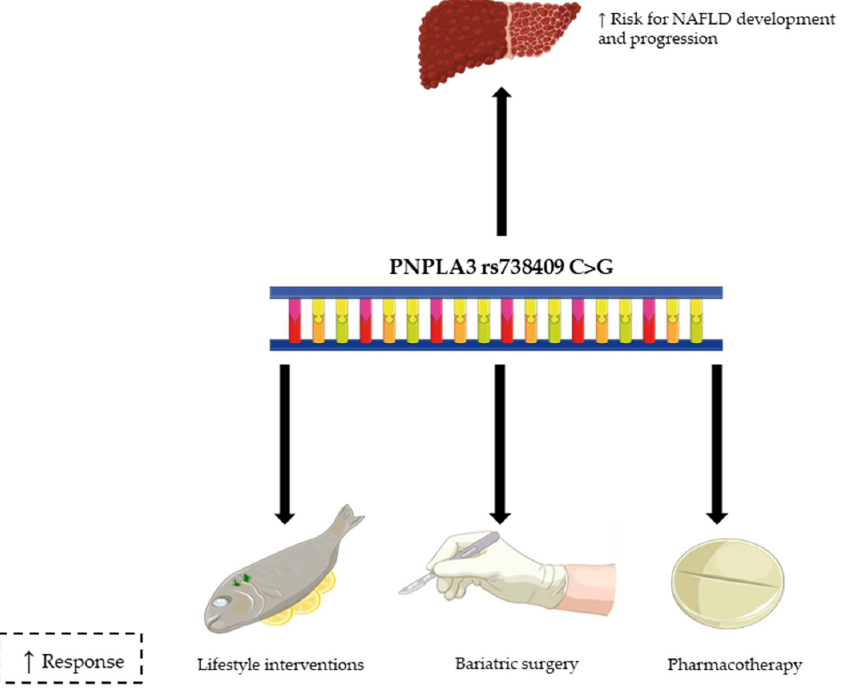
Figure 1. The role of PNPLA3 rs738409 C > G variant in NAFLD. PNPLA3 I148M is associated with NAFLD development and progression, and the interplay between this variant and environmental factors, including dietary habits, seems to be crucial in the pathophysiology of the disease. PNPLA3 I148M presence may also be related to an increased response to lifestyle interventions, bariatric surgery and certain types of therapeutic agents, such as the combination of sodium-glucose cotransporter 2 inhibitors and polyunsaturated fatty acid (PUFA). PNPL3: patatin-like phospholipase domain-containing protein 3; I148M (rs738409 C > G): isoleucine to methionine exchange at the amino acid position 148 due to cytosine to guanine transversion in rs738409); NAFLD: non-alcoholic fatty liver disease.